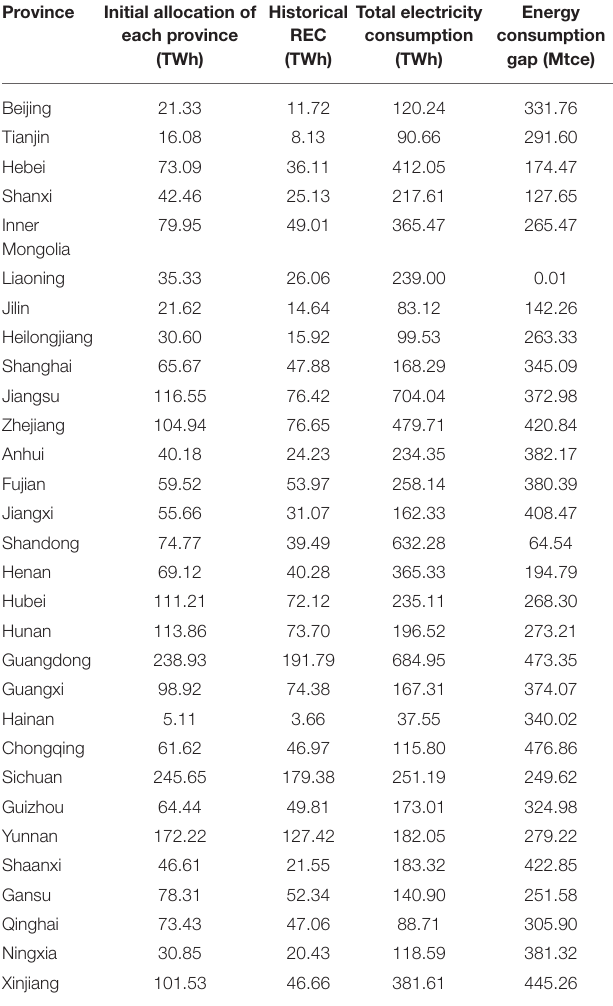
TABLE 4 | Input and output indicators for each province in 2020.